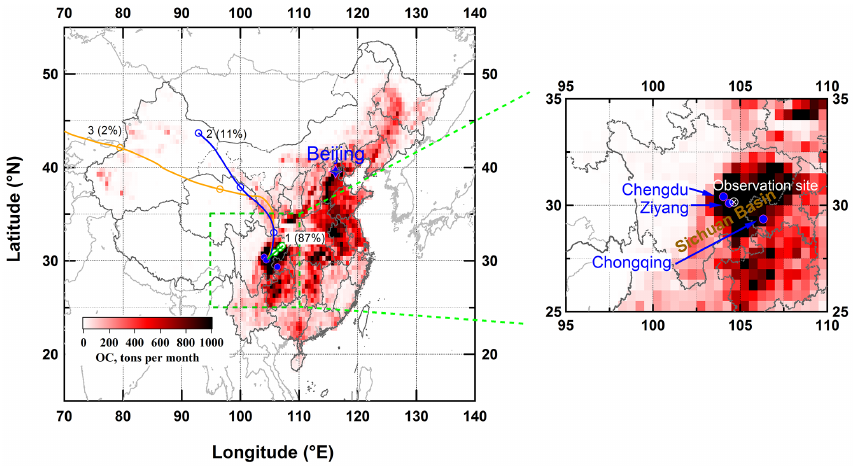
Figure 1. Location of the observation site in Ziyang in the Sichuan Basin. Back trajectories of air masses at the site calculated by HYSPLIT model are illustrated as lines (circles marking 24h intervals). The map of China is color-coded according to residential OC emissions in January 2010 modeled by Multi-resolution Emission Inventory for China (MEIC,